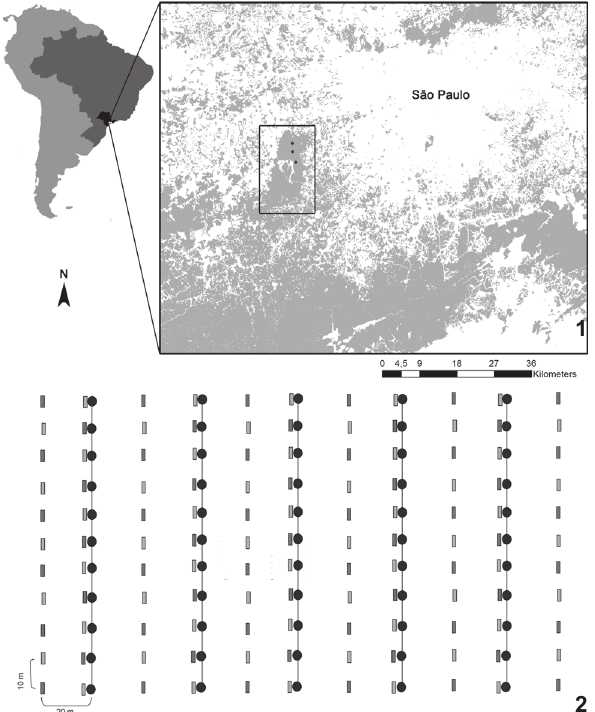
Figures 1-2. (1) Location of the Morro Grande Forest Reserve (high- lighted in a rectangle) in São Paulo State (black), Brazil, near to São Paulo City. Black dots represent the 2-ha trapping grids. Gray areas: forest; white areas: non-forest. (2) Trapping grids used to capture small mammals. Rectangles: Sherman traps; circles: pit- fall traps connected by drift-fences